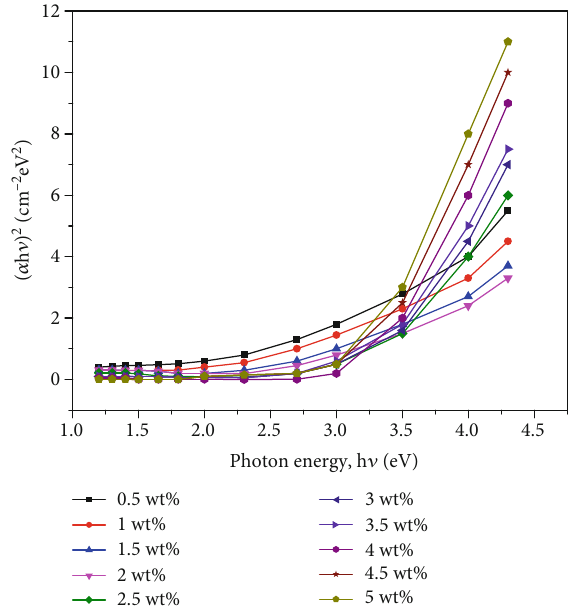
Figure 7: The ( α h υ ) 2 against photon energy ( h υ ) of the deposited ITiO fi lms of di ff erent doping concentrations from Ti-0.5wt% to Ti- 5.0wt%. Table 3: Energy gap ( E ) of ITiO fi lms at the temperature of 300 ° C. g